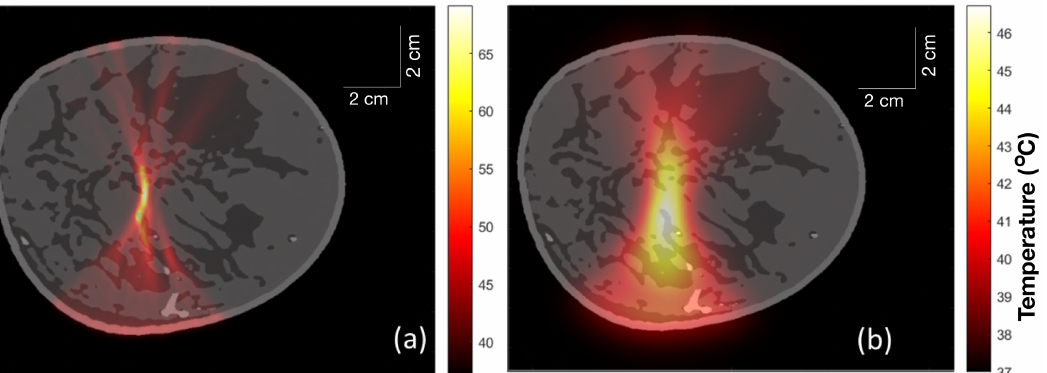
Figure 9. ( a ) Temperature distribution within the extremely dense breast just after HIFU was turned on for 5 s. ( b ) Temperature distribution in the extremely dense breast 1 min after turning on the HIFU for 5